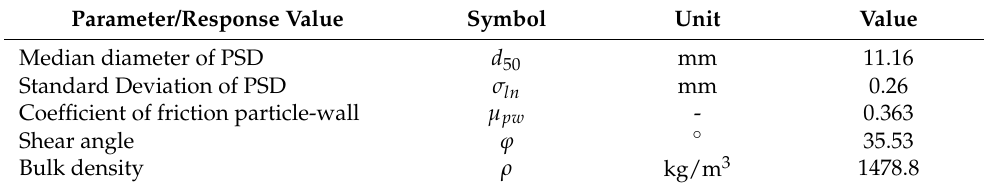
Figure 16. Particle size distribution of Gravel 8/16 and fitting of Log-normal distribution. Table 3. Values of Gravel 8/16 determined in experimental investigations.